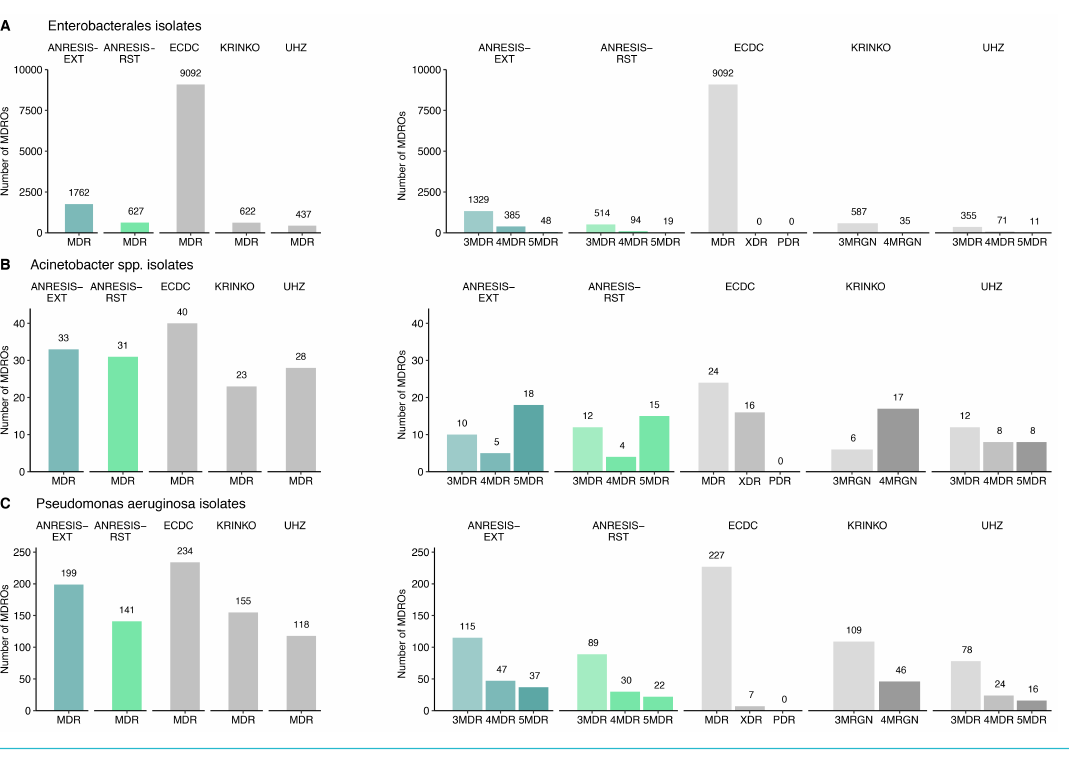
Figure 3: Number of isolates meeting the respective MDRO criteria is displayed. In the left figures, the total number of isolates (Enterobac- terales n = 41,785, Acinetobacter spp. n = 419, Pseudomonas aeruginosa n = 2,919) fulfilling the MDRO criteria is shown. In the right figures, the MDR isolates are displayed according to their degree of multidrug resistance. The number ahead of MDR indicates against how many an- tibiotic categories an isolate was found to be resistant. ECDC, European Centre for Disease Prevention and Control; KRINKO, Commission for Hospital Hygiene and Infection Prevention; UHZ, University Hospital Zurich; ANRESIS, Swiss Centre for Antibiotic Resistance; RST, restricted; EXT, extended; MDR, multiple drug resistance; MDRO, multiple drug-resistant organisms; MRGN, multi-resistant gram-negative; PDR, pan drug resistance – isolates are non-susceptible to all agents in all antimicrobial categories; XDR, extensive drug resistance – isolates are non- susceptible to at least one agent in all but two or fewer antimicrobial categories.